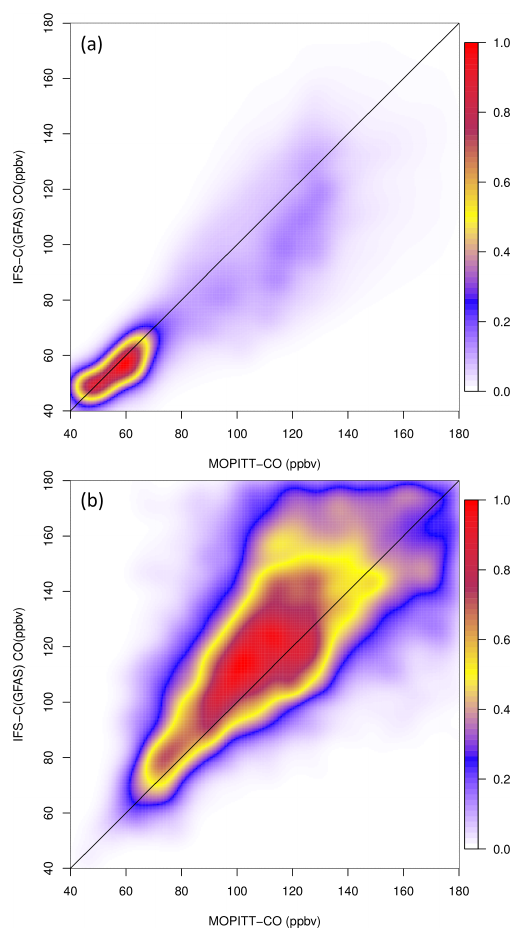
Figure 2. Normalized density plot of monthly mean surface con- centration for 2013 from the MOPITT instrument on board the Terra satellite plotted against CO surface concentration analysed by CAMS. Points are grouped in locations for which fires were not de- tected by MODIS (a) and locations where fire activity was observed during that month (b)